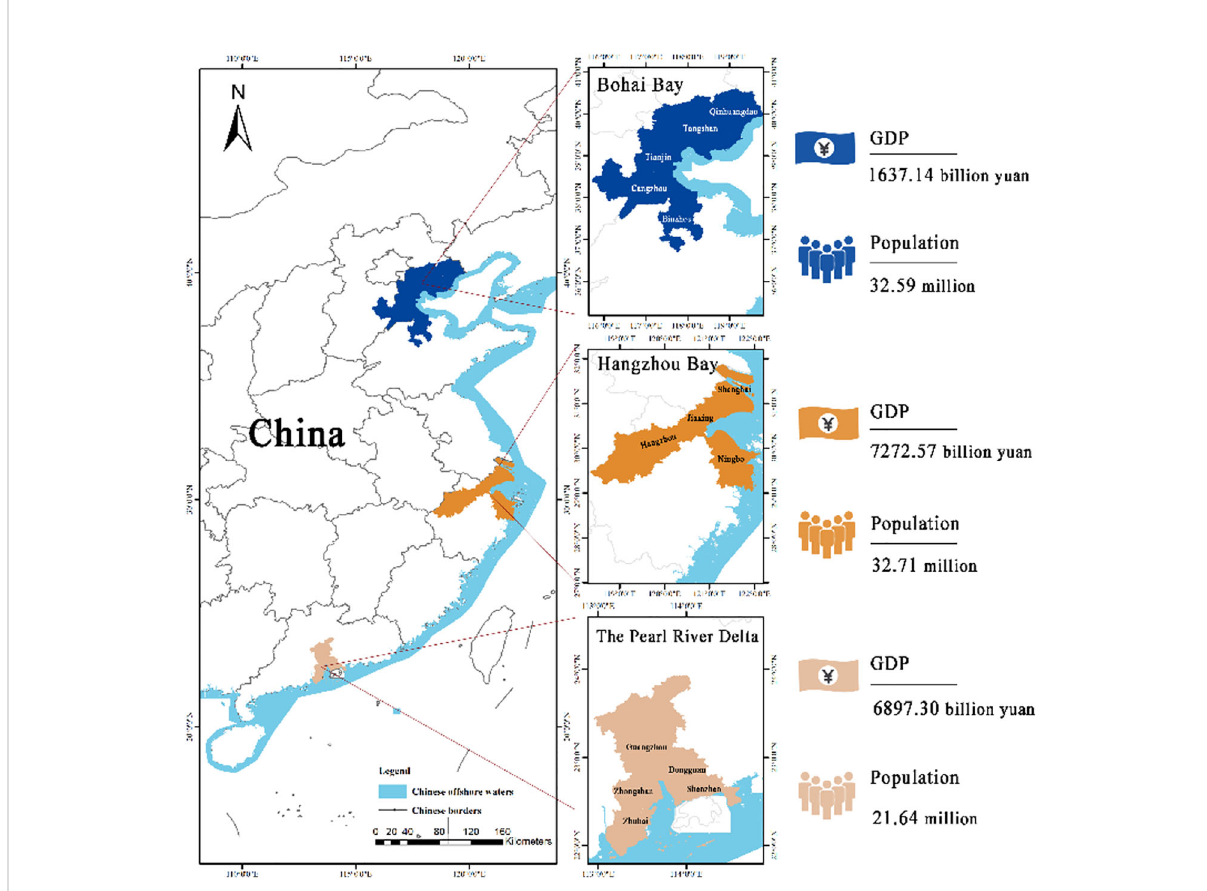
FIGURE 1 Location of Bohai Bay, Hangzhou Bay, and the Pearl River Delta in China. GDP and population are counted in